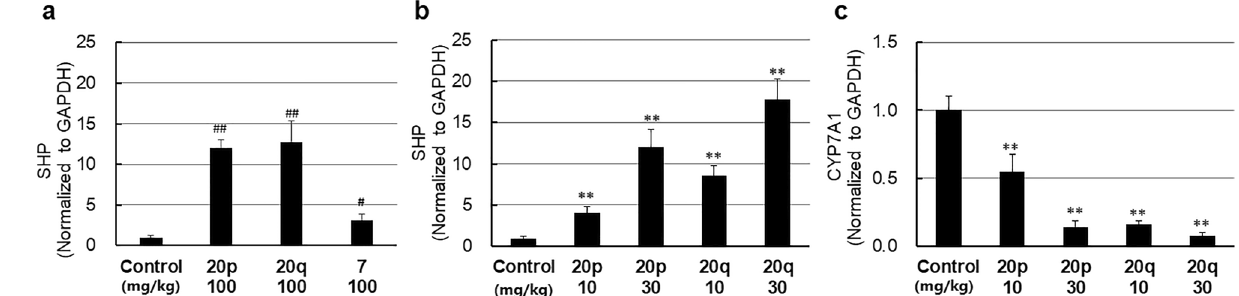
Figure 7. ( a ) Induction of SHP mRNA in mice liver by 20p and 20q following a single oral dose (100 mg/ kg), compared with fexaramine 7 (100 mg/kg). ( b ) Induction of SHP mRNA in mice liver by 20p and 20q (10, 30 mg/kg). # p < 0.05, ## p < 0.01, significant difference from a control group, as analyzed by Student’s t-test., **p < 0.01 significant difference from a control group, as analyzed by Dunnett’s multiple comparison test. n = 5, control n = 10. ( c ) Repression of CYP7A1 in mice liver by 20p and 20q following a single oral dose (10, 30 mg/ kg). **p < 0.01 significant difference from the control group, as analyzed by Dunnett’s multiple comparison test. n = 5, control n = 10.